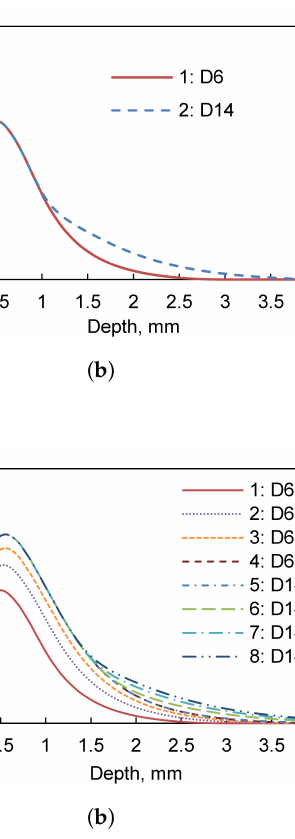
Figure 10. Evolution of equivalent plastic strain (PEEQ) of combined hammering.